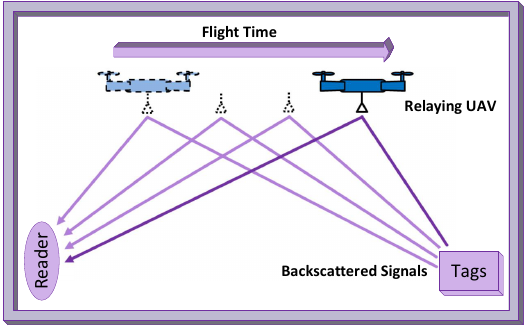
Figure 42. UAV-based relay with antenna array in